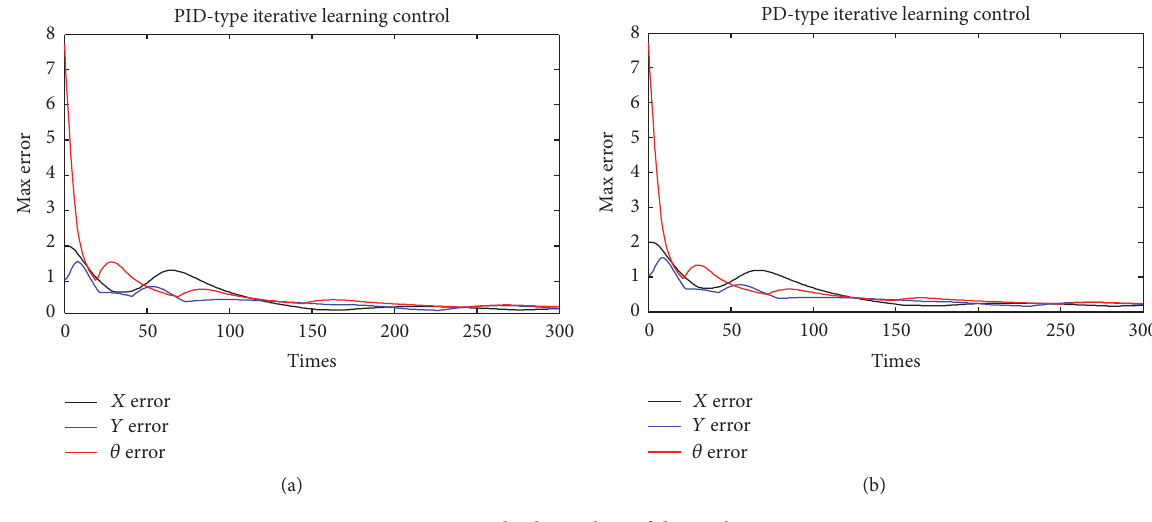
Figure 3: Max absolute values of the tracking